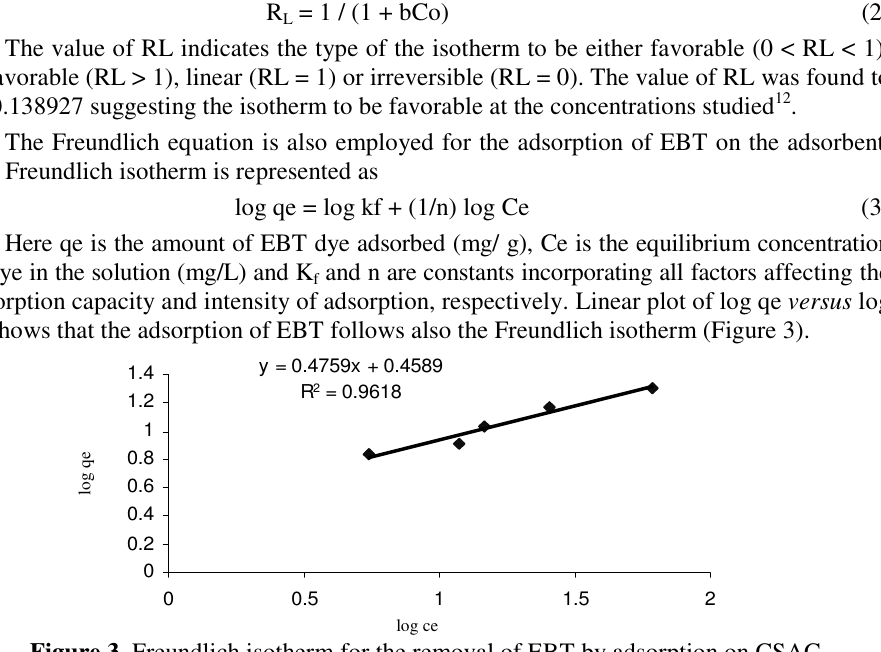
Figure 3. Freundlich isotherm for the removal of EBT by adsorption on